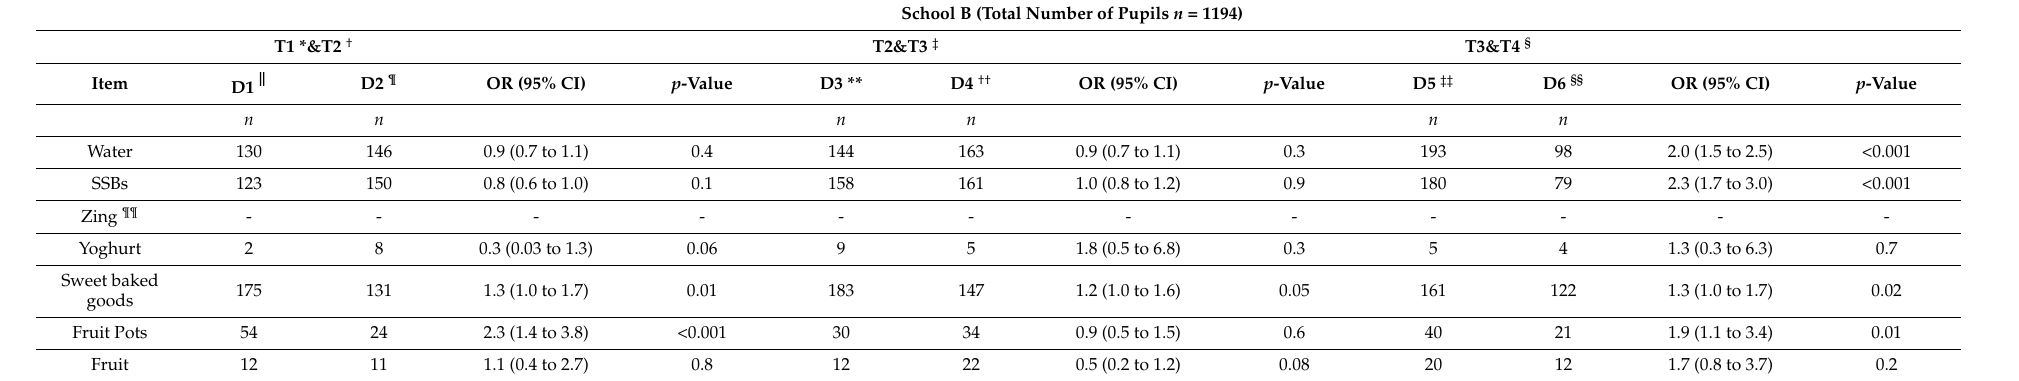
Table 4. School B: Effect of intervention on pupil’s food and drink purchases across time periods with OR, 95% CI and p -value.